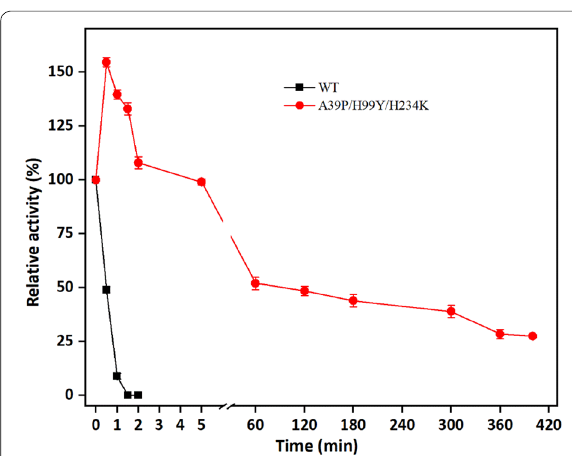
Fig. 5 Kinetic stability of the wild‑type UDH and the triple mutant (A39P/H99Y/H234K) at 59 °C. Remaining activity was measured at 30 °C and 37 °C for the wild‑type UDH and the triple mutant (A39P/ H99Y/H234K)